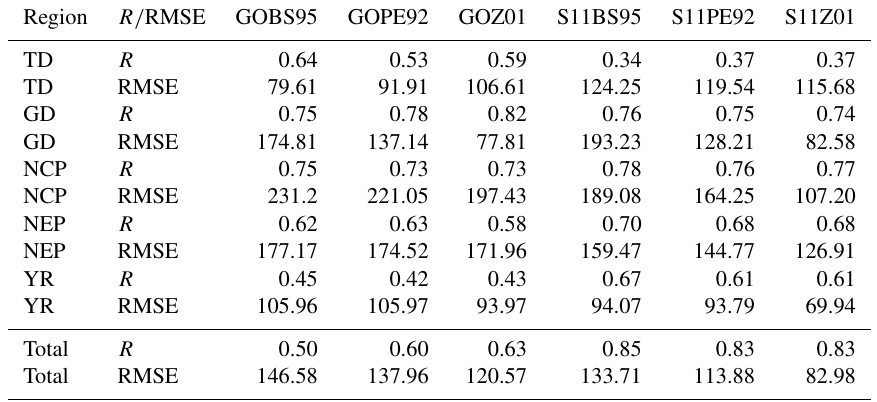
Table 5. Correlation coefficient ( R ) and root mean square error (RMSE) between the model and observations for PM 10 over five subregions and for all of the stations over whole China in Fig. 7 for six experiments listed in Table